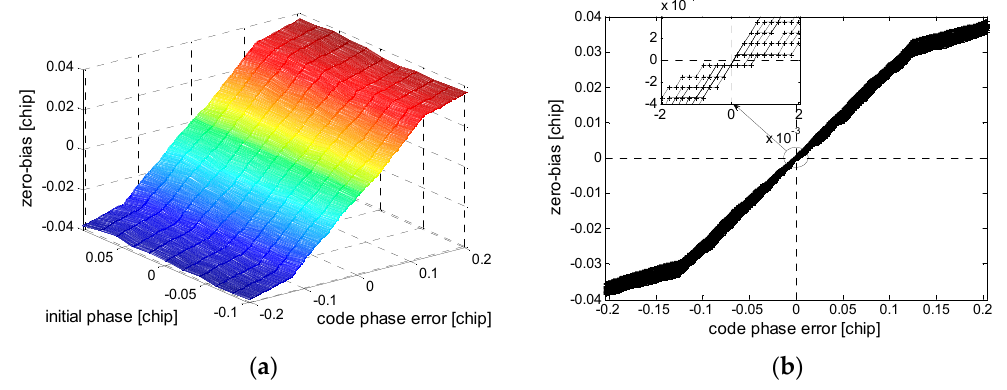
Figure 4. The variation curve of the zero deviation of the BOCs (1, 1) signal with the initial phase and code phase estimation deviation of the signal. ( a ) Three-dimensional view; ( b ) Two-dimensional Table 1. Frequently used notations.